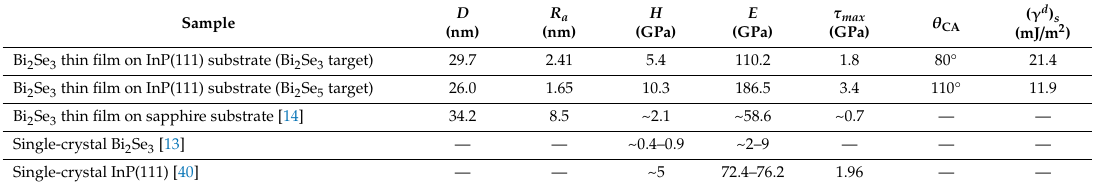
Table 1. The microstructural parameters, nanomechanical properties, contact angle and surface energy of Bi 2 Se 3 thin films. The mechanical properties of InP(111) are also listed.